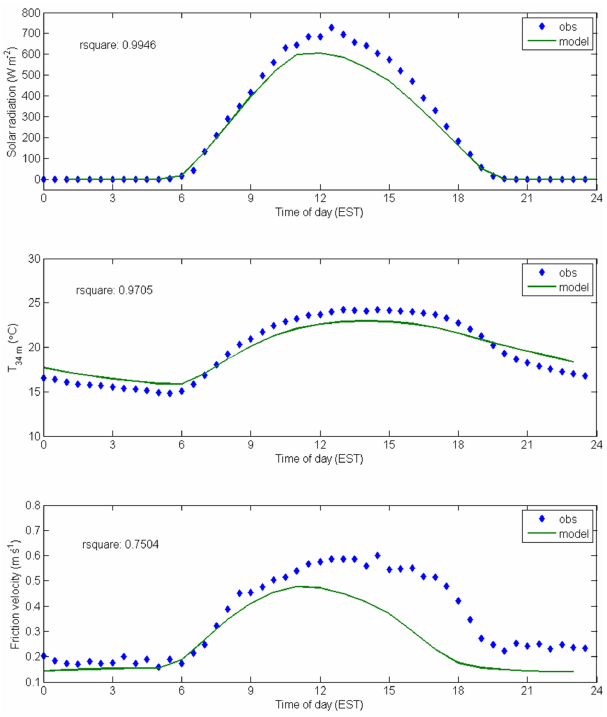
Fig. 7. Observed and modeled (SCM) diurnal variation of solar radiation, above-canopy temperature at 34m, and above-canopy friction velocity at 46m for August 2008 at the UMBS AmeriFlux tower. The correlation coefficient, r 2 , between the observed and the modeled data is noted in each plot.